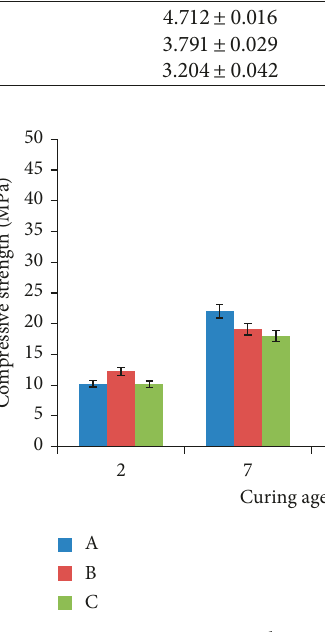
Figure 1: Compressive strength at 2, 7, 14, and 28days for all brands of OPC at w/c 0.5.